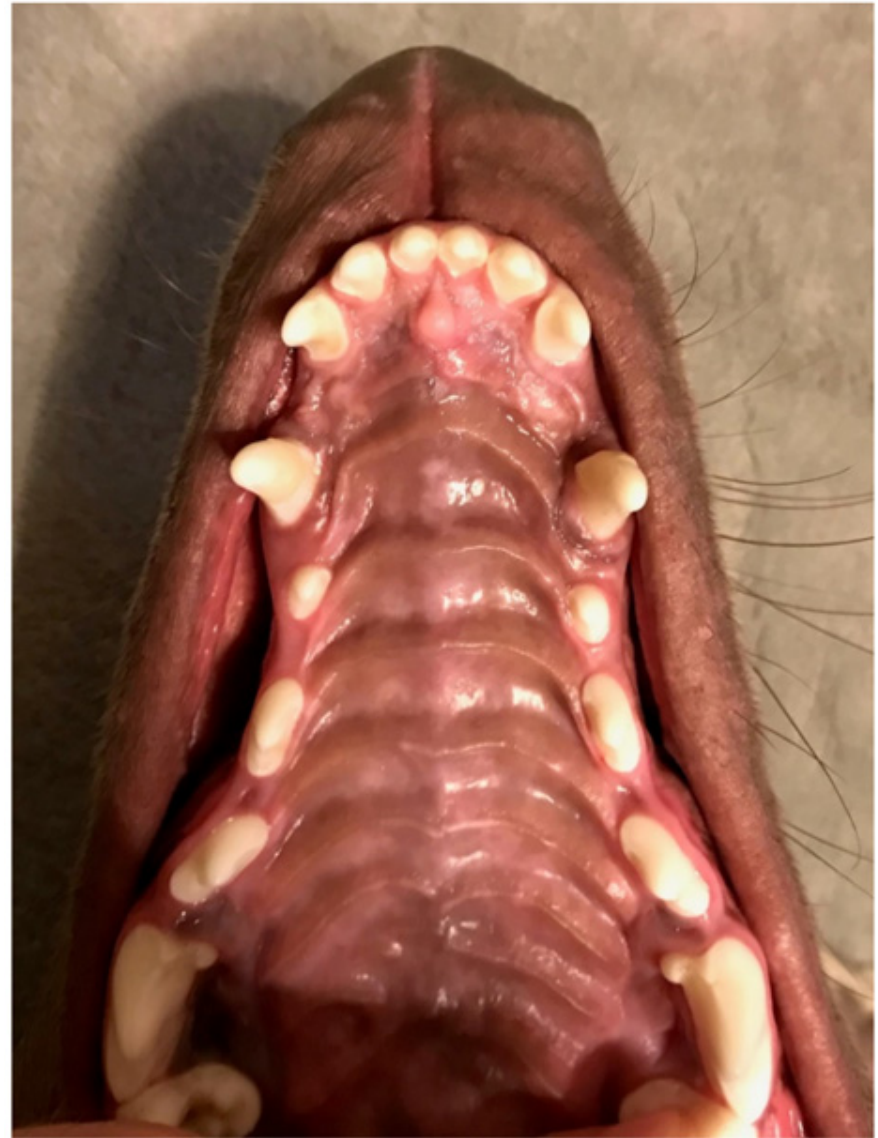
Figure 11. Third case. Permanent teeth in the maxilla 4 months after the start of the treatment. No trace of traumatic occlusion.